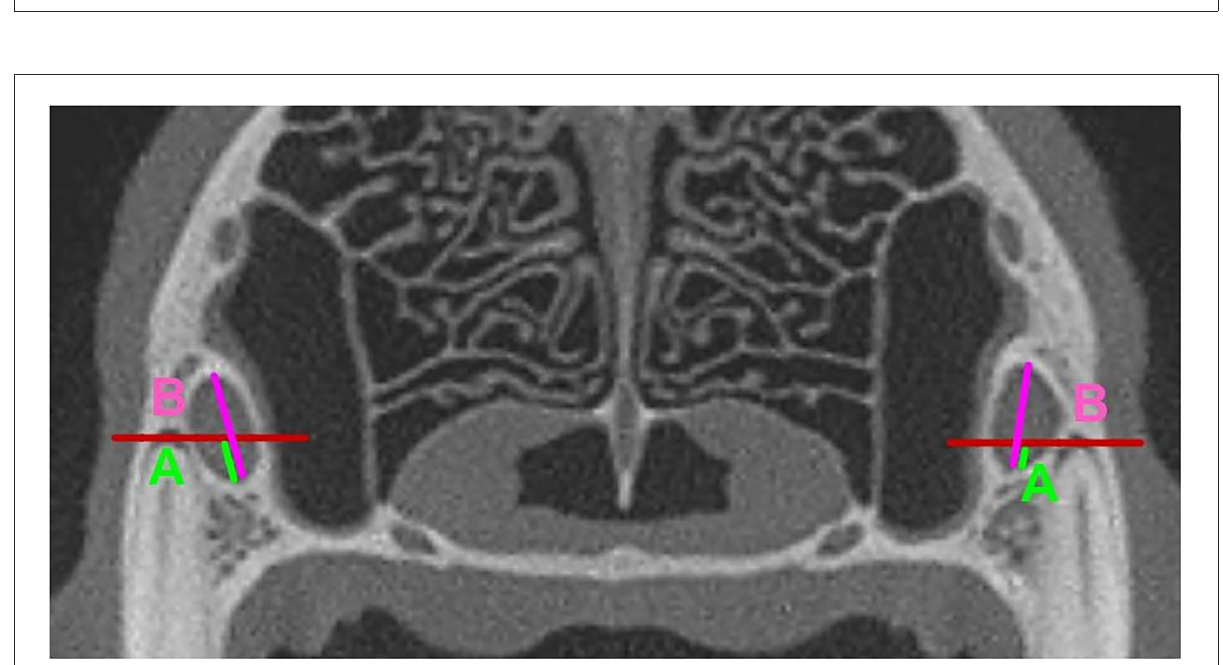
FIGURE4 Mesial Roots of the P4. (A) (neon Green): Vertical Height of the portion of the IOC in Section 5. (B) (fuchsia): Total Vertical height of the IOC. The portion (ratio) of the IOC in Section 5 was calculated as A/B.